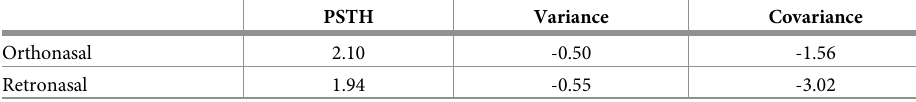
Table 1. Parameter b for LN model fits to MC spiking statistics in Fig 5.